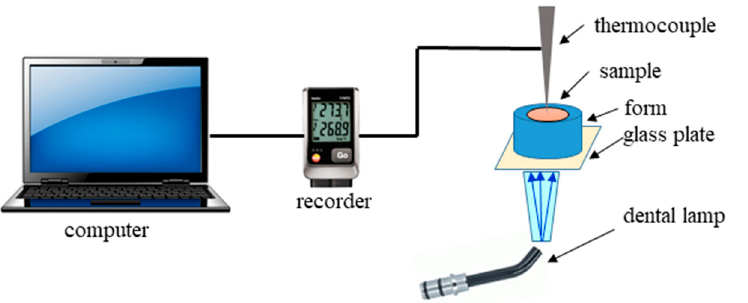
Figure 10. Schematic diagram of the system used to measure temperature changes during the photopolymerization process for the tested composite materials.